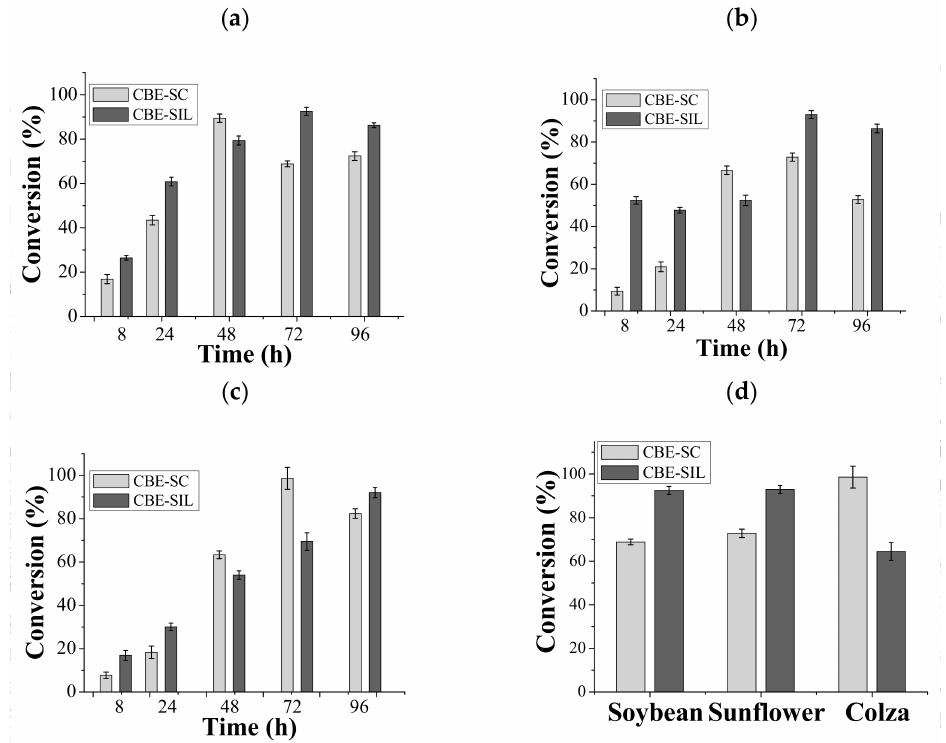
Figure 6. Time course of ethyl ester conversion using lipase from Burkholderia cepacia immobilized by covalent binding for different oils: soybean ( a ), sunflower ( b ) or colza ( c ). Experiments considered under a 40 ◦ C, 96 h of reaction and stirring at 80 rpm. In image ( d ) a comparison between the three oil types for aliquots taken at 72 h of reaction under the already described conditions, is